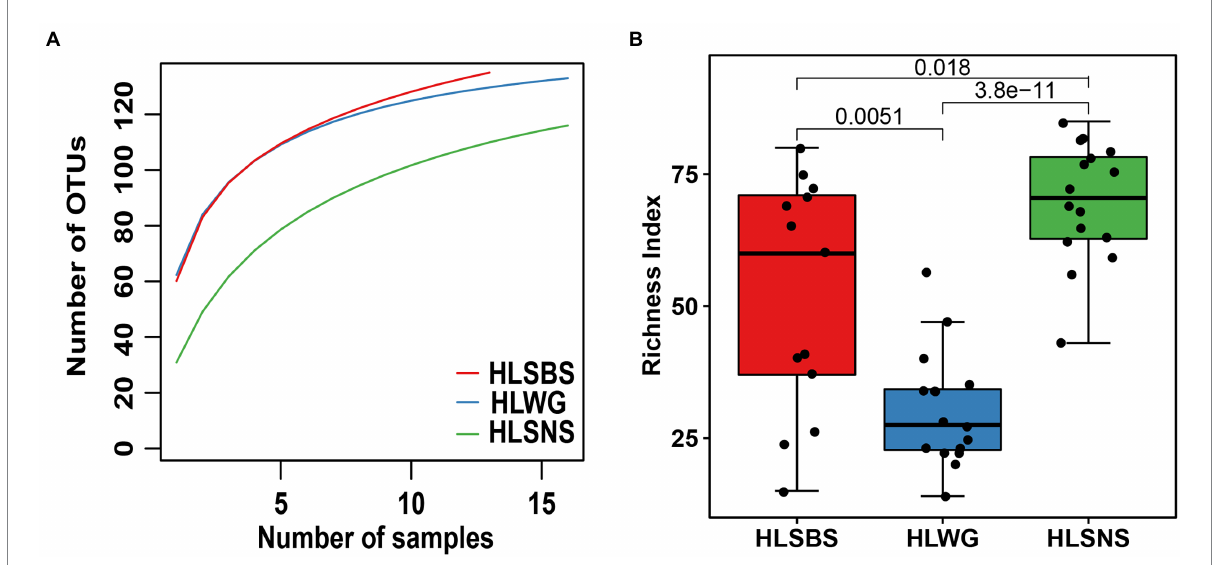
FIGURE 1 Alpha diversity index of the ectomycorrhizal fungal community of Picea crassifolia . Rarefaction of ectomycorrhizal fungal operational taxonomic units (OTUs) in three sites (A) ; Richness index (B) . Data were analyzed using nonparametric method followed by the Wilcoxon test for (B) . HLSBS, HeLanShan-BeiSi; HLWG, HaLaWuGo; and HLSNS, HeLanShan-NanSi.